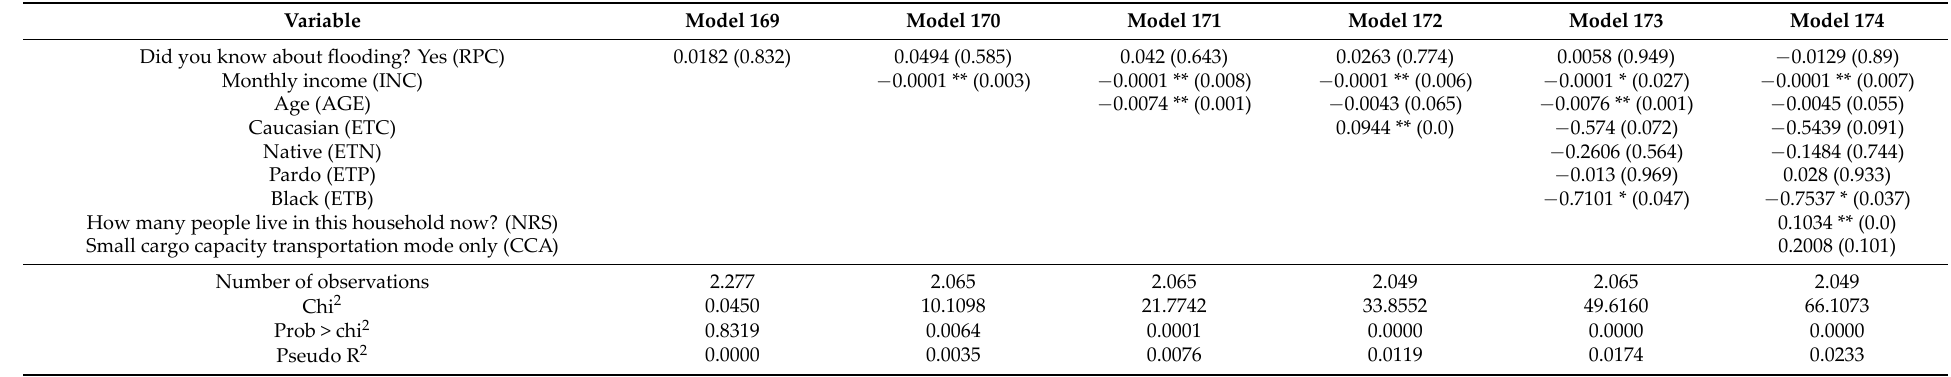
Table 6. Logit regression analysis for set (c): residents outside the flood protection system for risk‑response alternative RP1: evacuate the area. Acronyms follow the definitions in Table